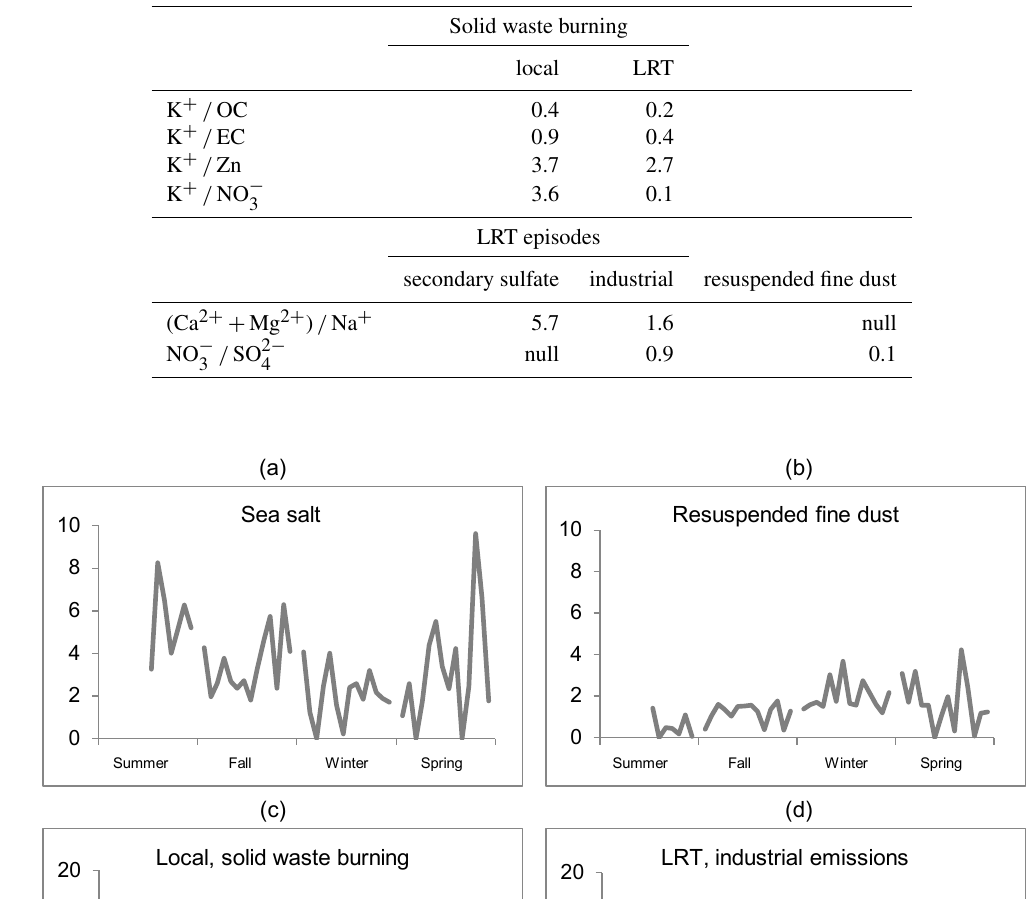
Table 4. Enrichment factors.